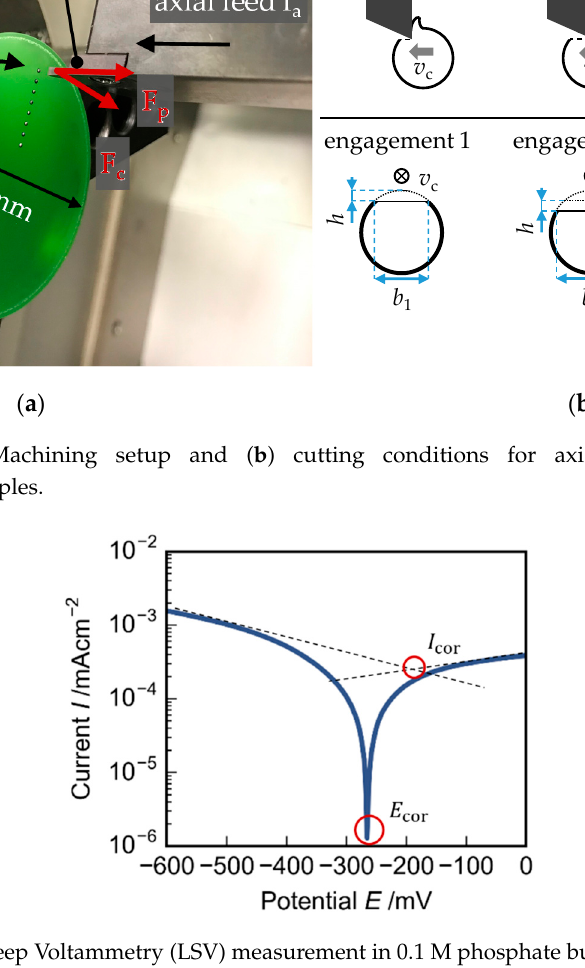
( b ) Figure 5. Micrographs of synthesized samples: ( a ) X210Cr12 and ( b ) 41Cr4. The thermal history of droplets from both alloys was calculated using a previously developed droplet cooling model [24]. Figure 6a shows the thermal histories for the process conditions from Table 1 and the experimental falling distance of 6.5m before the droplets are quenched. Both alloys are fully solid in the argon atmosphere before they are collected in oil. The solidification rate as a function of droplet diameter is shown in Figure 6b. A small variation in droplet diameter (e.g., ±10 µm) will only have a minor effect on the solidification rate (process conditions are marked with red circles). We conclude that microstructure development should be highly reproducible due to this wide process window.